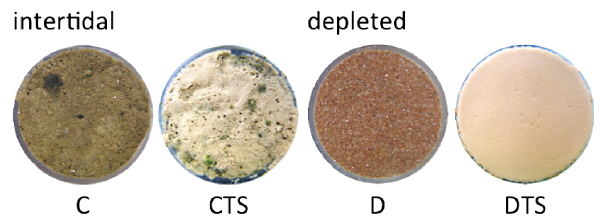
Fig. 1. Surface photographs of four sediment core treatments af- ter 18h: (C) intact intertidal sediment, (CTS) intertidal sediment covered with TS, (D) organic-matter depleted sediment, and (DTS) depleted sediment covered with TS. Core diameter =